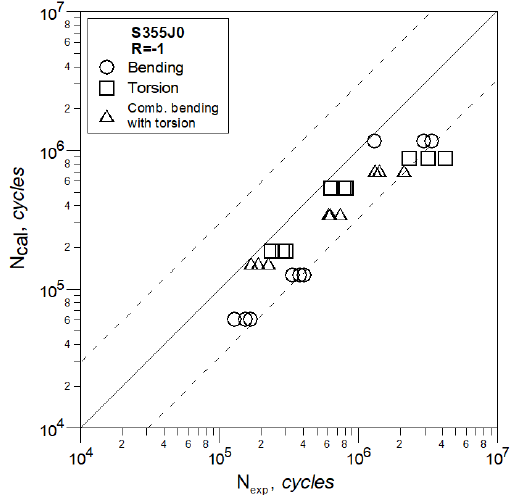
Figure 7. Comparison of the computational life N cal with the experimental N exp for R = − 1.